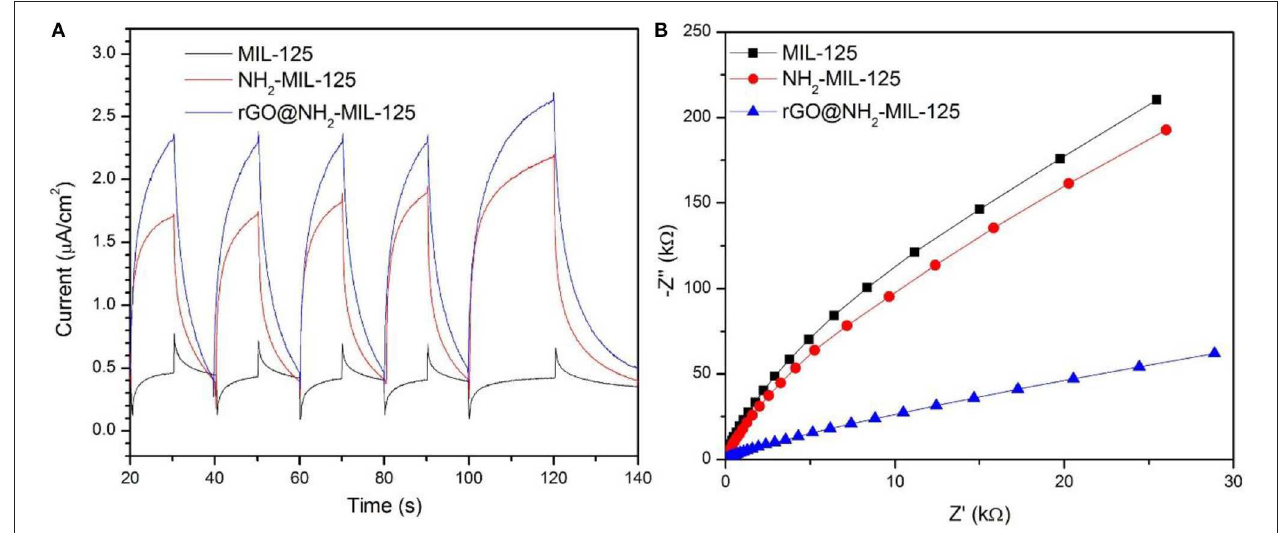
FIGURE 7 | (A) Photocurrent potential curves and (B) EIS Nyquist plots of the three as-prepared catalysts.